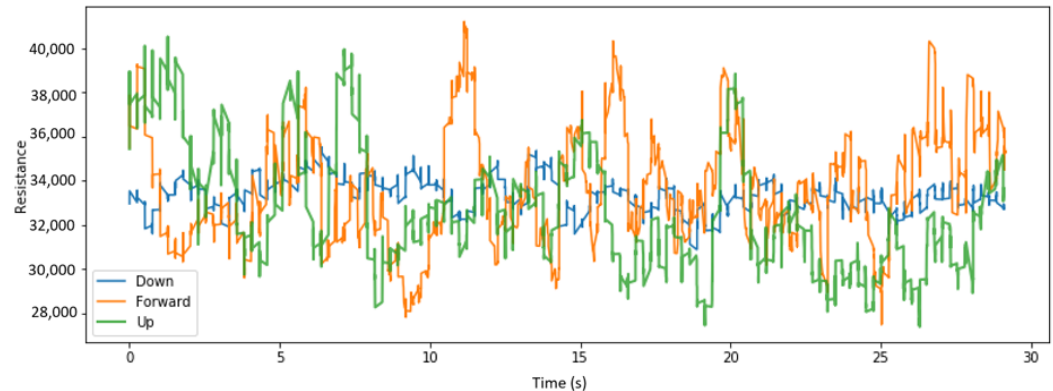
Figure 5. With center placement of short sensor, head tilt filtered data.